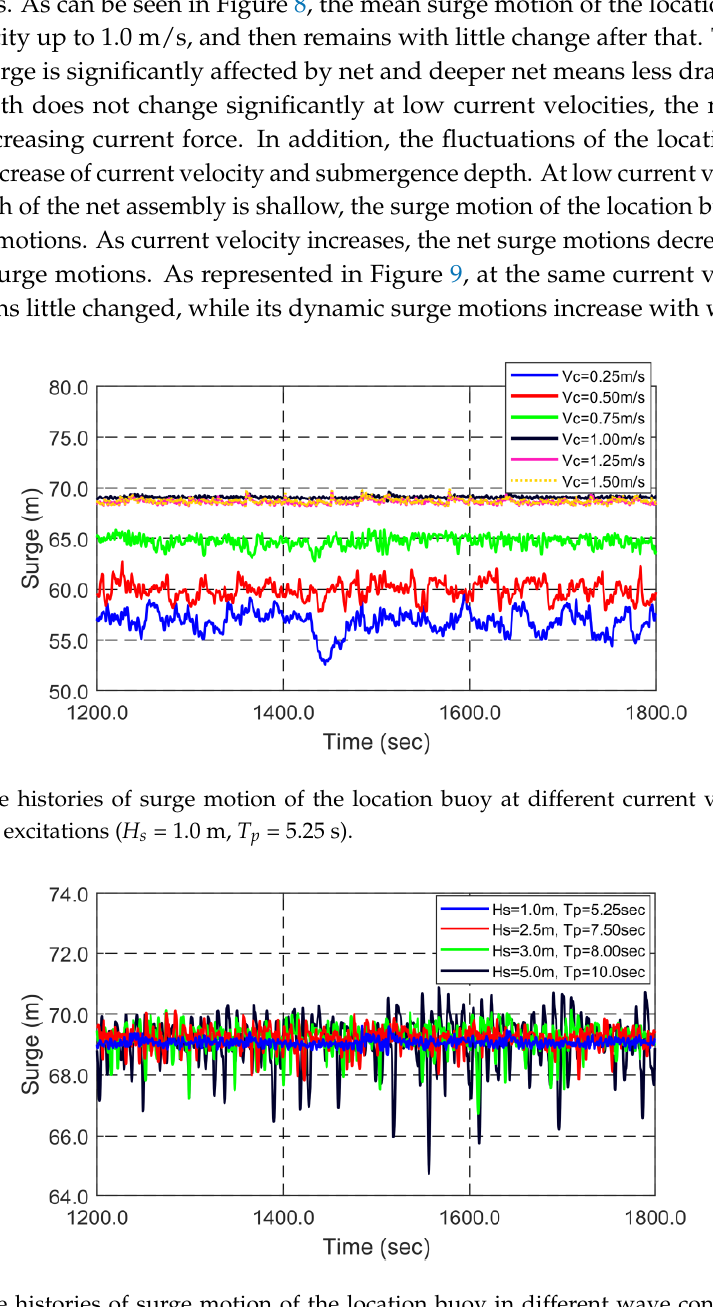
Figure 9. Time histories of surge motion of the location buoy in different wave conditions under identical current velocity ( V c = 1.0 m/sec). Table 4. Statistical results of surge motion of the location buoy, rope tension, and mooring tension for all simulated cases.